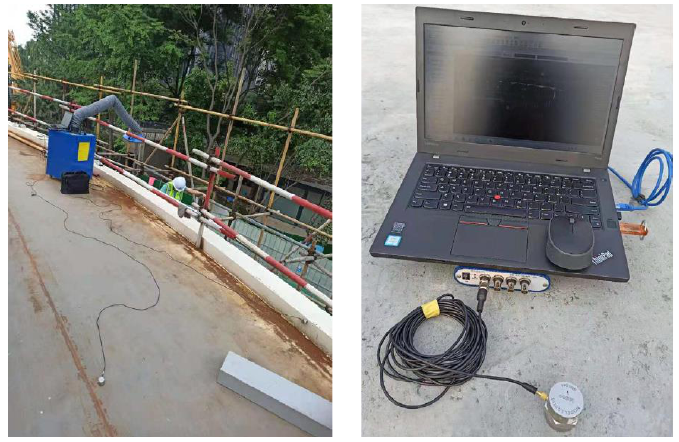
Figure 2. Instrumentation of the investigated pedestrian bridge with accelerometers.